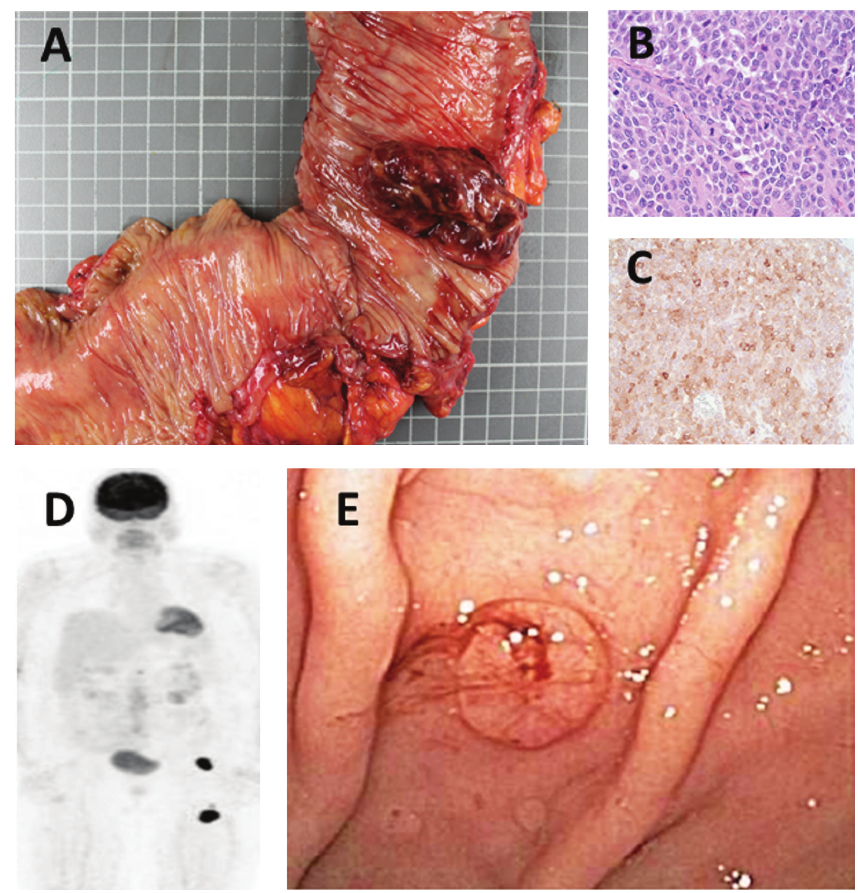
Figure 1: Extended right hemicolectomy specimen containing a 5.6 cm exophytic, partially obstructing lesion (a). Histology of colon lesion showing sheets of medium- to large-sized tumor cells with irregular nuclear contours and vesicular nuclei, intermixed with numerous mitotic figures ((b), hematoxylin-eosin, 400x). Immunohistochemistry of colon lesion diffusely positive for melan-A (c). PET scan showing areas of metastatic disease (left renal mass, L1 vertebral body), but prominent intensity of the left inguinal region and left anterior thigh (d). Endoscopy showing one of many pigmented lesions throughout the stomach